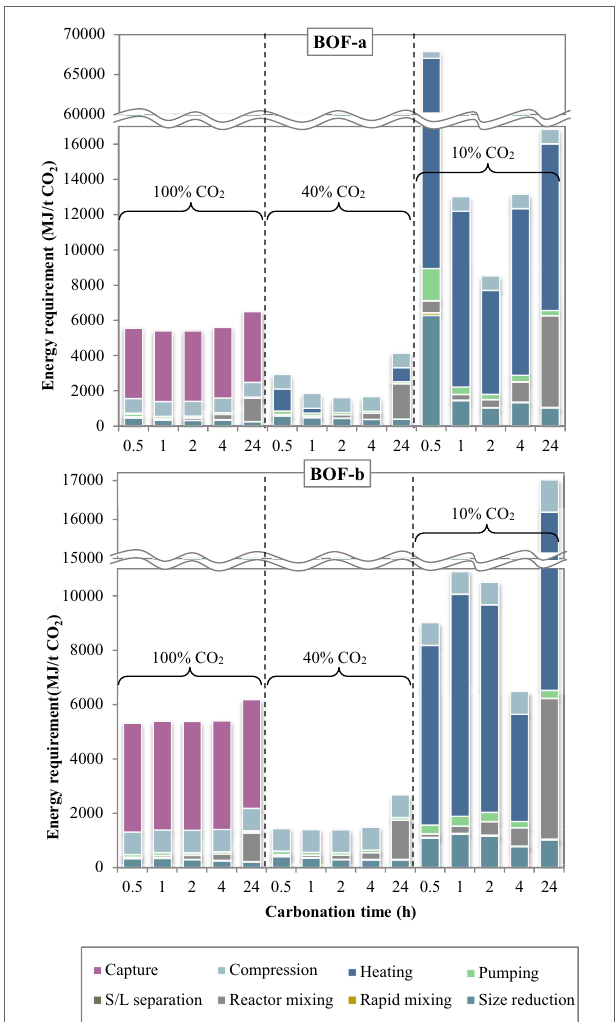
FigUre 3 | energy requirement of each unit operation as a function of the carbonation conditions (slurry-phase route)